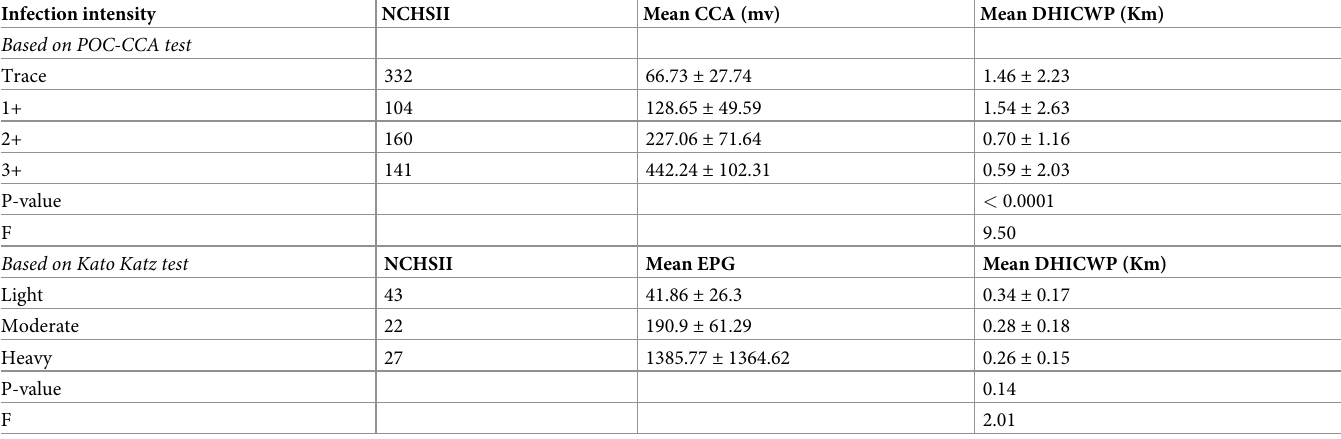
Table 5. Variations between the mean distances of houses of infected children to the nearest water points according to infection intensities. Infection intensity